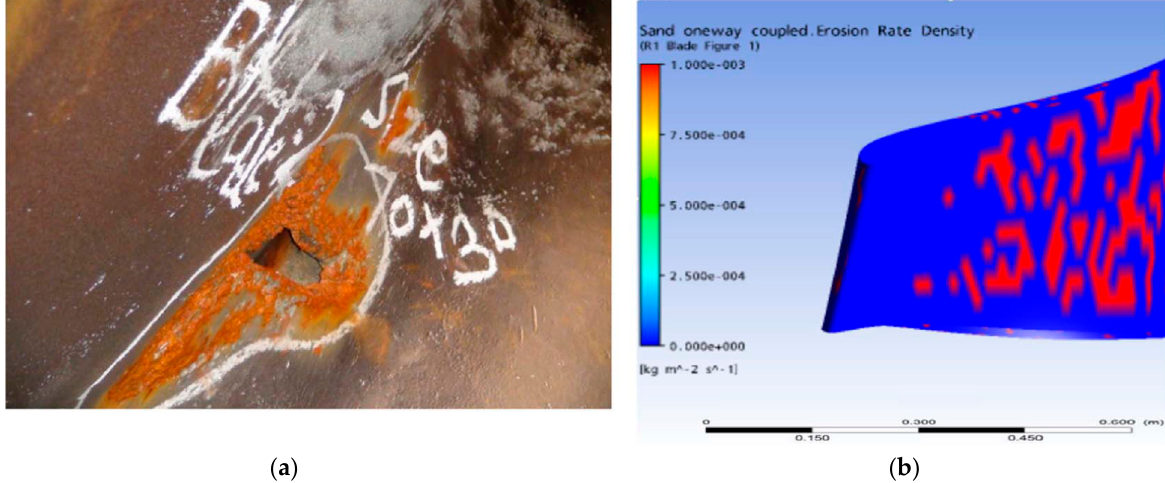
Figure 7. Runner at Tarbela dam hydroelectric project (TDHP), ( a ) at actual site, ( b ) erosion rate density profile [17].